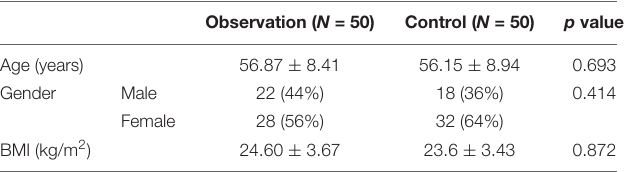
TABLE 1 | Patients’ demographic